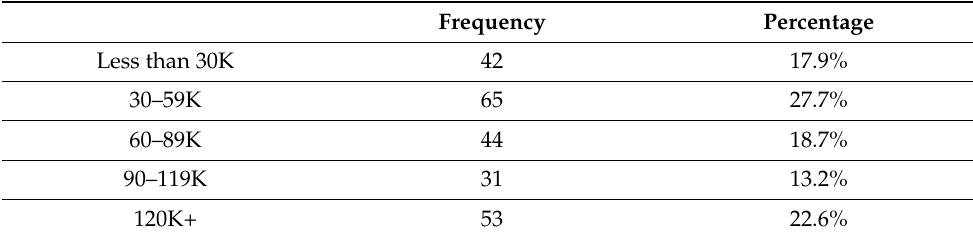
Table 2. Study sample’s reported annual